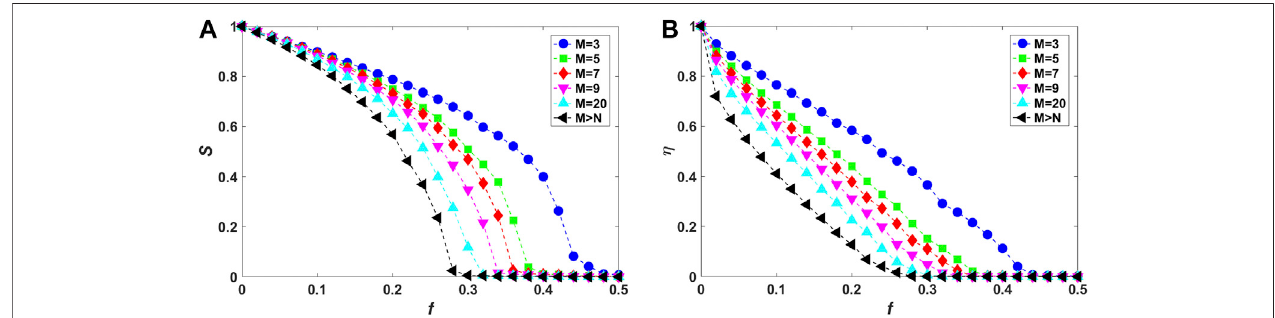
FIGURE 2 | (Color online) Vulnerability analysis of isolated local-world networks (corresponding to interdependence strength q (cid:2) 0 . 0) after intentional attack on a fraction f of high-degree nodes. (A) Relative size S of the local-world networks as a function of the fraction f of removed nodes; (B) residual communication ef fi ciency η versus the fraction f of removed nodes. Results are obtained by averaging over 50 independent realizations on local-world networks, which are constructed with size N (cid:2) 10 , 000, m (cid:2) 3, and average degree 〈 k 〉 (cid:2) 2 m (cid:2) 6 for different M ( M (cid:2) 3 , 5 , 7 , 9 , 20 and M > N ). M (cid:2) 3 and M > N correspond to two special cases of local- world model, exponential and scale-free network, respectively.